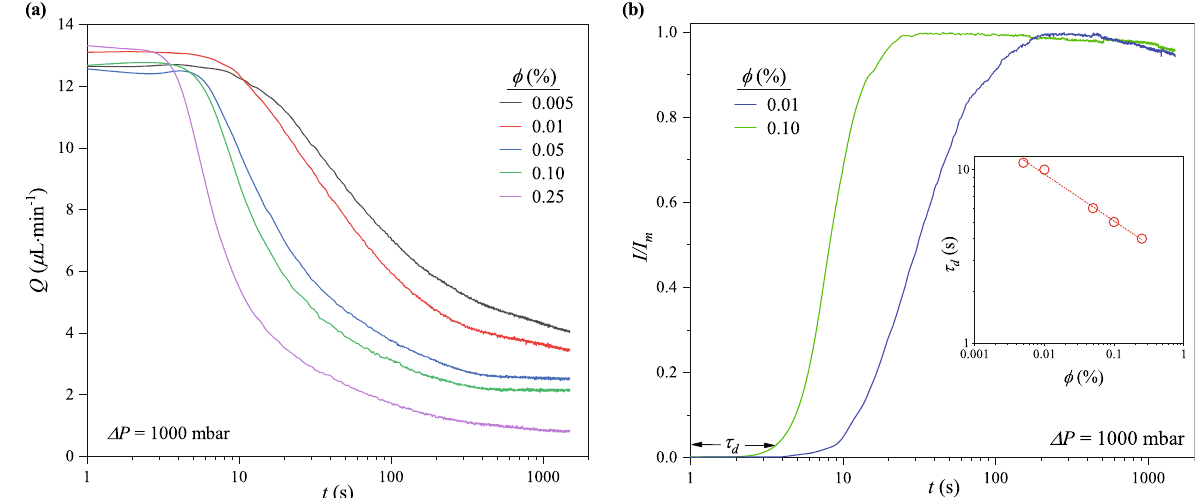
Figure 2. ( a ) Suspension flowrate decays over time at different φ for (cid:31) P = 1000 mbar. Even at high φ , the devices never fully clog due to continued filtration of the suspension medium through the clogs. Three specific processes are present in each decay curve. They correspond to the initial and final plateau, and the power-law decay between them. ( b ) Evolution of the normalized fluorescence intensity ( I / I m ) around the midpoint of the channels exit region for (cid:31) P = 1000 mbar. I / I m increases as particles begin to sieve into the channels where w c ≈ d p . The time, t , when I / I m significantly increases corresponds to τ d , which denotes the end of the initial plateau in the flowrate decay curves. Inset: τ d depends on φ with a power-law exponent of − 1 4 . τ d of the least concentrated cases ( φ = 0.005% and 0.01% ) is approximately equal to τ v . The dip in I / I m at longer times is due to photo-bleaching arising from prolonged exposure to the excitation light